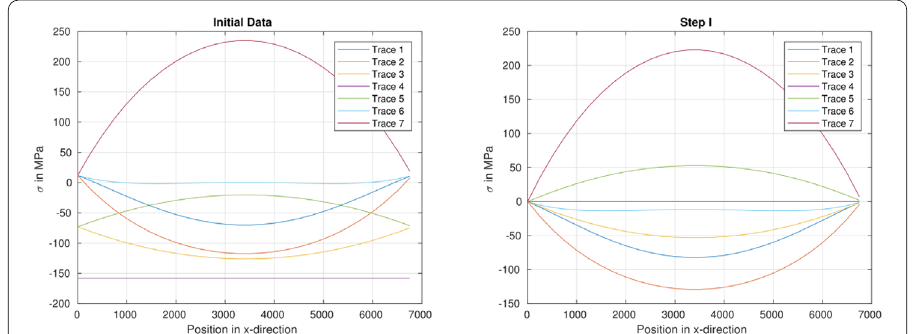
Figure 9 Left: Example input for a fork-mounted single-carrier. Right: After